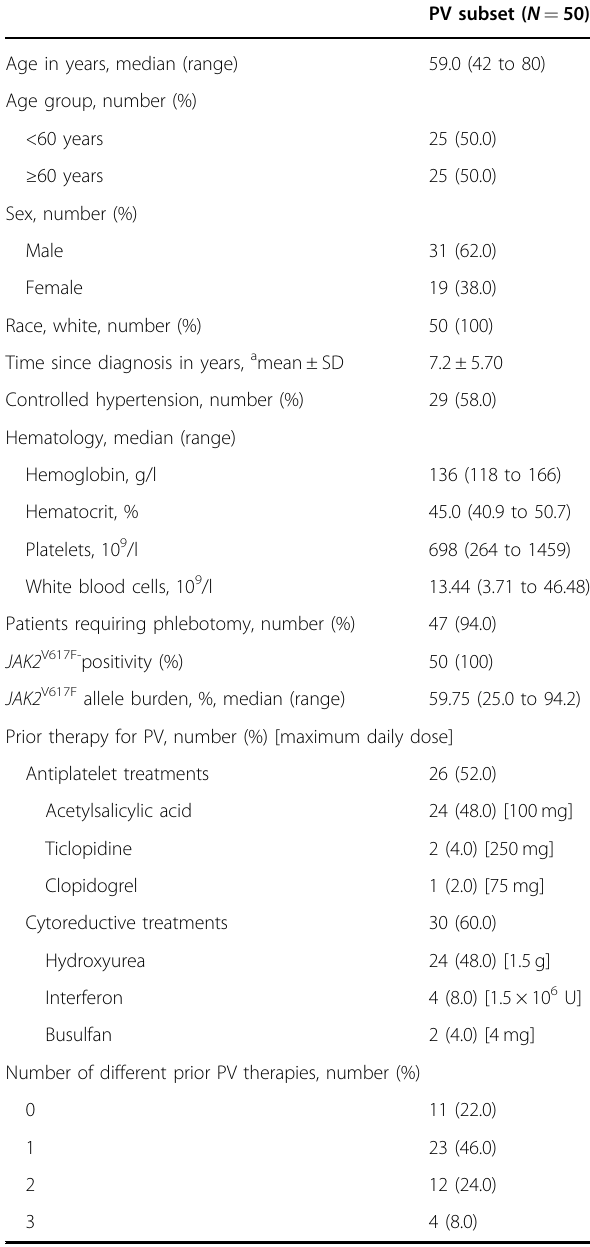
Table 1 Demographics and disease characteristics for the treated PV subset at real